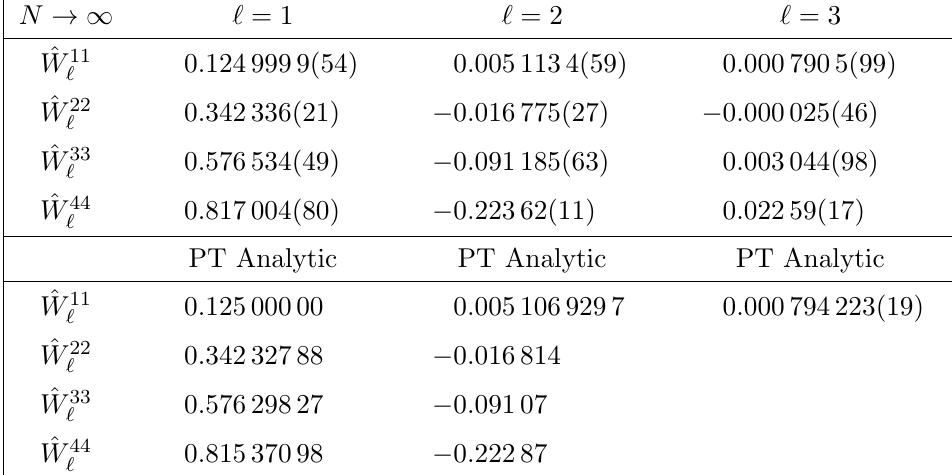
Table 5. Perturbative coe(cid:14)cients for ^ W RR